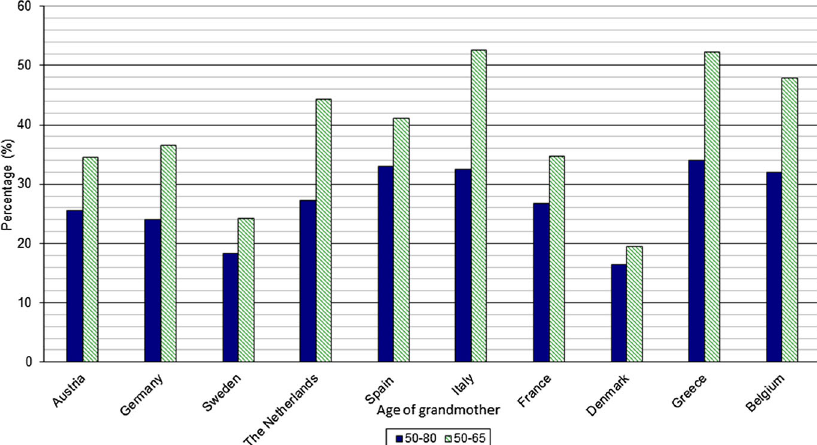
Fig. 1 Percentage of grandmothers who take care of their grandchildren (weekly). Source : SHARE 2004